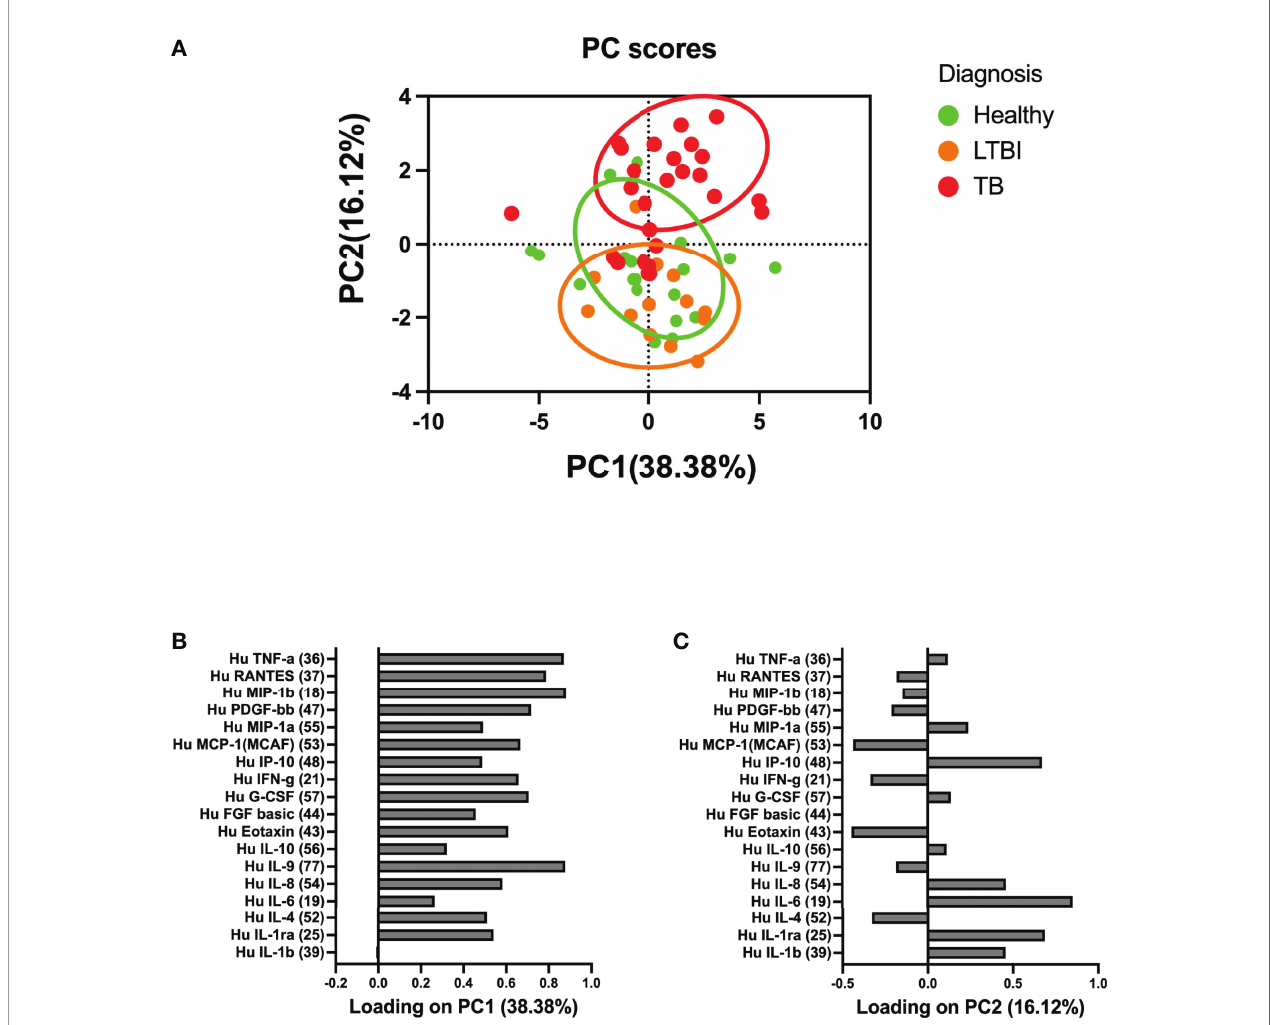
FIGURE 1 | Principal component analysis (PCA) of the association between circulatory cytokines and TB disease states. (A) Circulatory cytokines separate according to whether individuals are healthy, latent TB infected, or with active TB disease. (B) PC1 accounted for 38.38% of the variance observed in the data set. (C) PC2 accounted for 16.12% of the variance observed in the data set. PC2 was used to de fi ne the association between circulatory cytokine and whether individuals were healthy, LTBI, or those who had active TB. Each dot represents a participant score on the loading